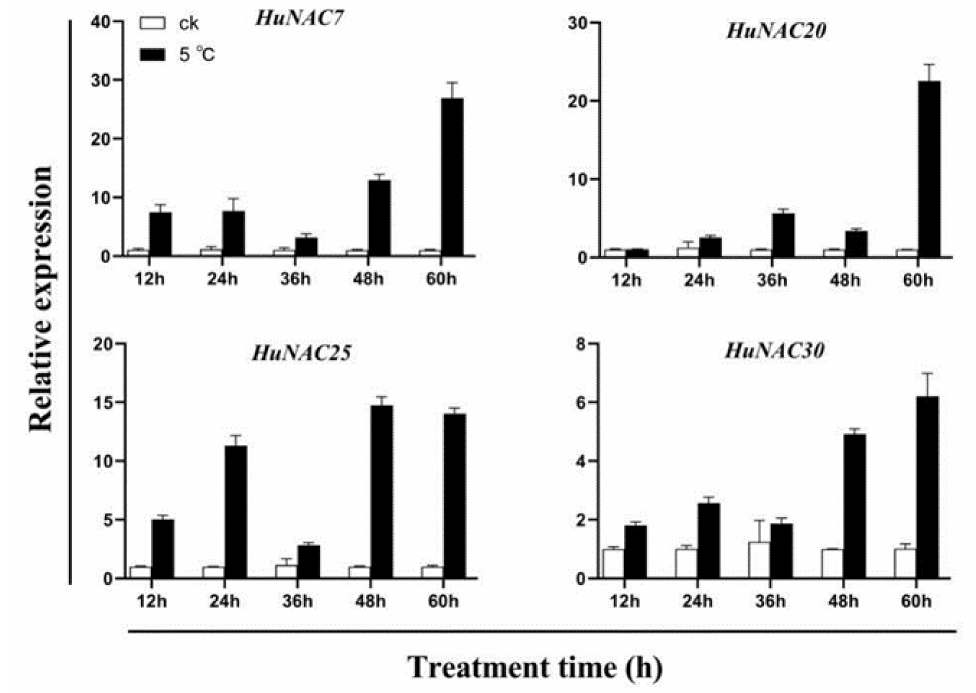
Figure 5. Expression analyses of HuNAC7 , HuNAC20 , HuNAC25 , and HuNAC30 under cold stress. Three biological replicates were used and bars represent the relative expression of different genes under cold